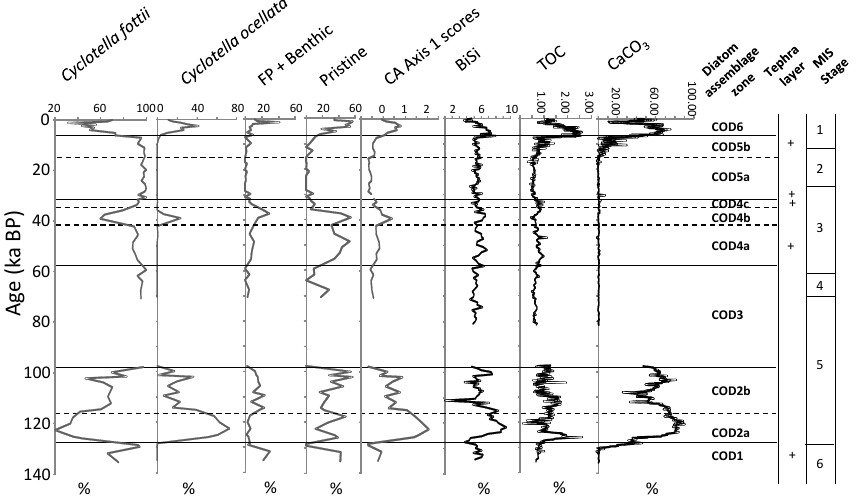
Fig. 6. Comparison of summary diatom data with selected geochemical data from Vogel et al. (2010b), on a chronological timescale, showing the location of major tephra layers. (FP = facultative planktonic; CA = correspondence analysis; BiSi = biogenic silica; TOC = total organic carbon; CaCO 3 = calcium carbonate, measured by loss on ignition). Boundary ages of Marine Isotope Stages (MIS stages) from Imbrie et al. (2007) are shown for